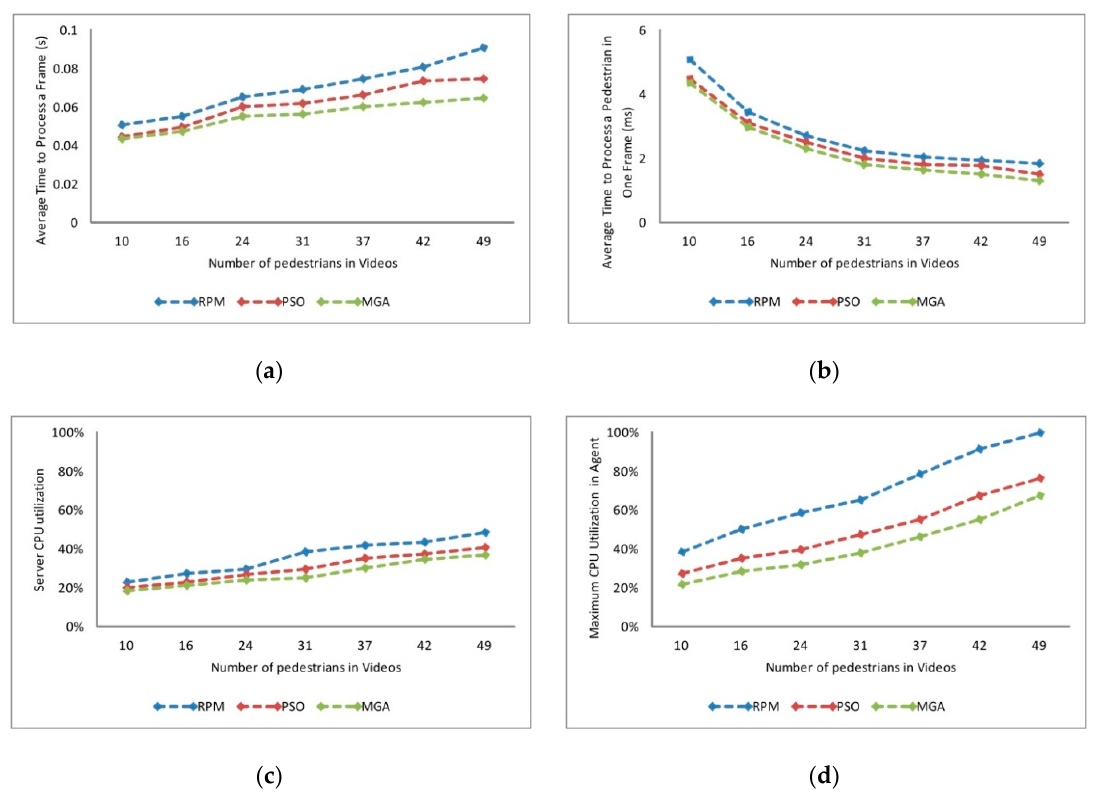
Figure 7. Performance comparison of processing time and CPU utilization for different number of pedestrians in videos. ( a ) Comparison of the average time for processing a frame; ( b ) comparison of the average time to identify a pedestrian; ( c ) comparison of the CPU utilization on the server side; ( d ) comparison of the maximum CPU utilization among the four agents.